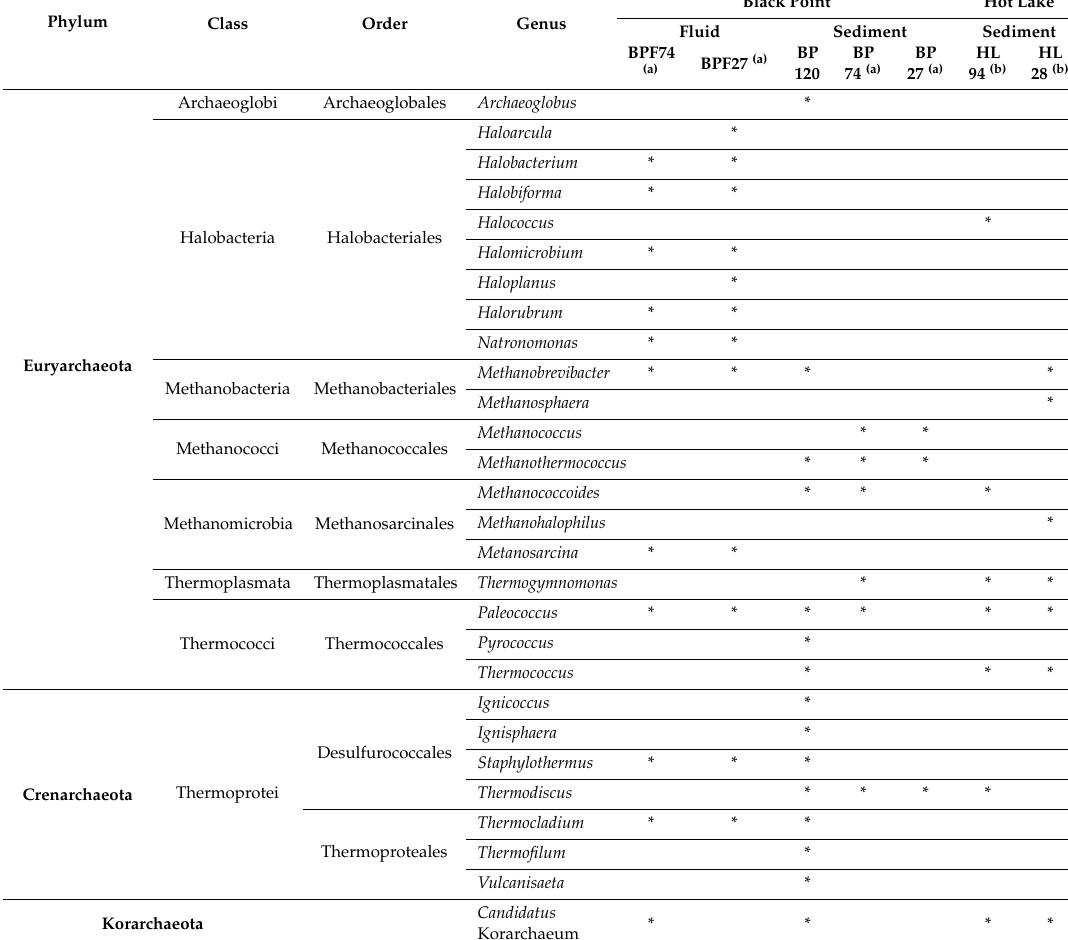
Table 6. Archaeal class, order, and genus distribution in fluids and sediments from Black Point (BP120, BP74, and BP27) and Hot Lake (HL94 and HL28) sites, as elucidated by Illumina sequencing technology.